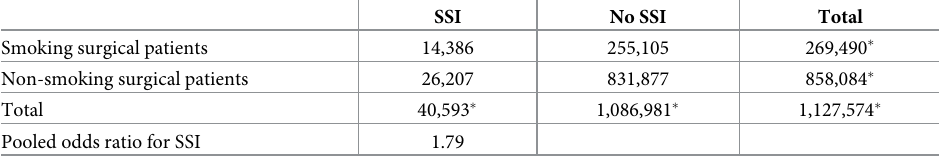
Table 2. Estimated annual expected number of smoking and non-smoking surgical patients having a SSI in Aus- tralian public hospitals.